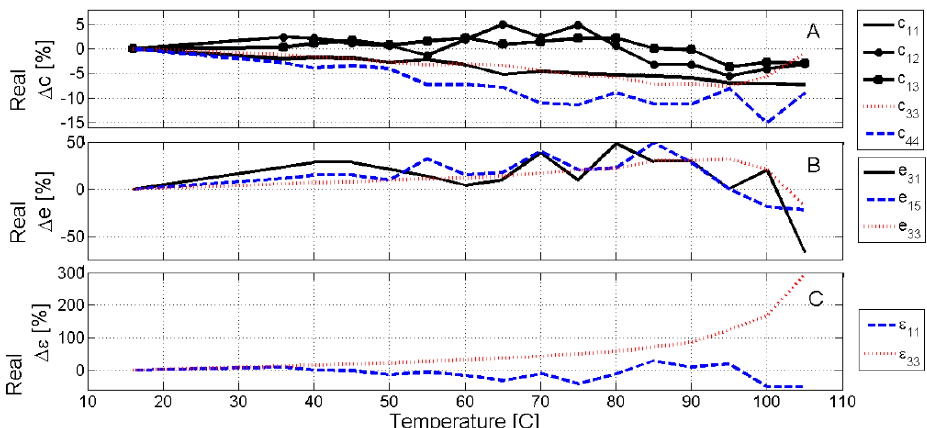
Figure 6. Thermal evolution of the real part of the elastic, dielectric, and piezoelectric parameters. Parameters related with the TH mode (high sensitivity) are represented in red. Those related with the radial modes are represented in black and those related with the complex resonances C 1 and C 2 in blue.